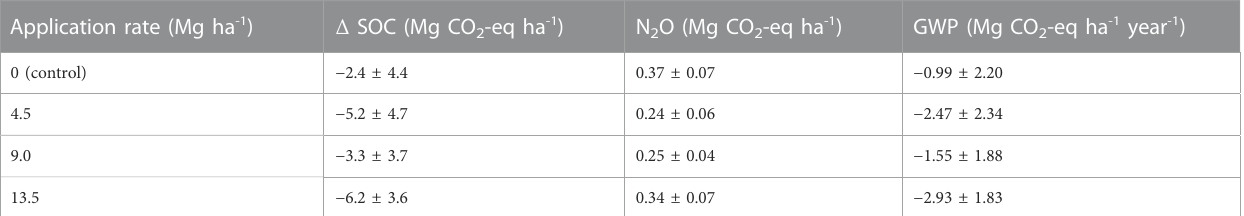
TABLE5ChangesinSOCstocks,cumulativeN 2 Oemissionsandglobalwarmingpotential(GWP)evaluatedinthestudybycompostapplicationrateoverthe2-year experimental period (2018 – 2020). Values are means (n = 4) ± standard errors. Application rate (Mg ha -1